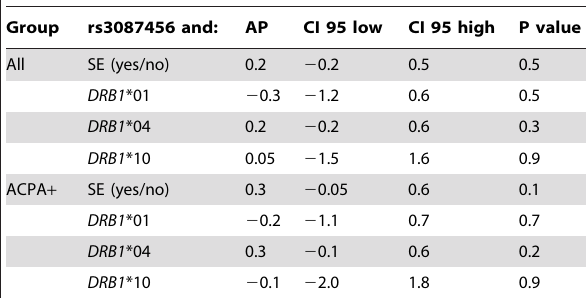
Table 2. Summary data of the interaction analysis for HLA- DRB1 SE allelic groups and SNP rs3087456 for the Swedish cohort.